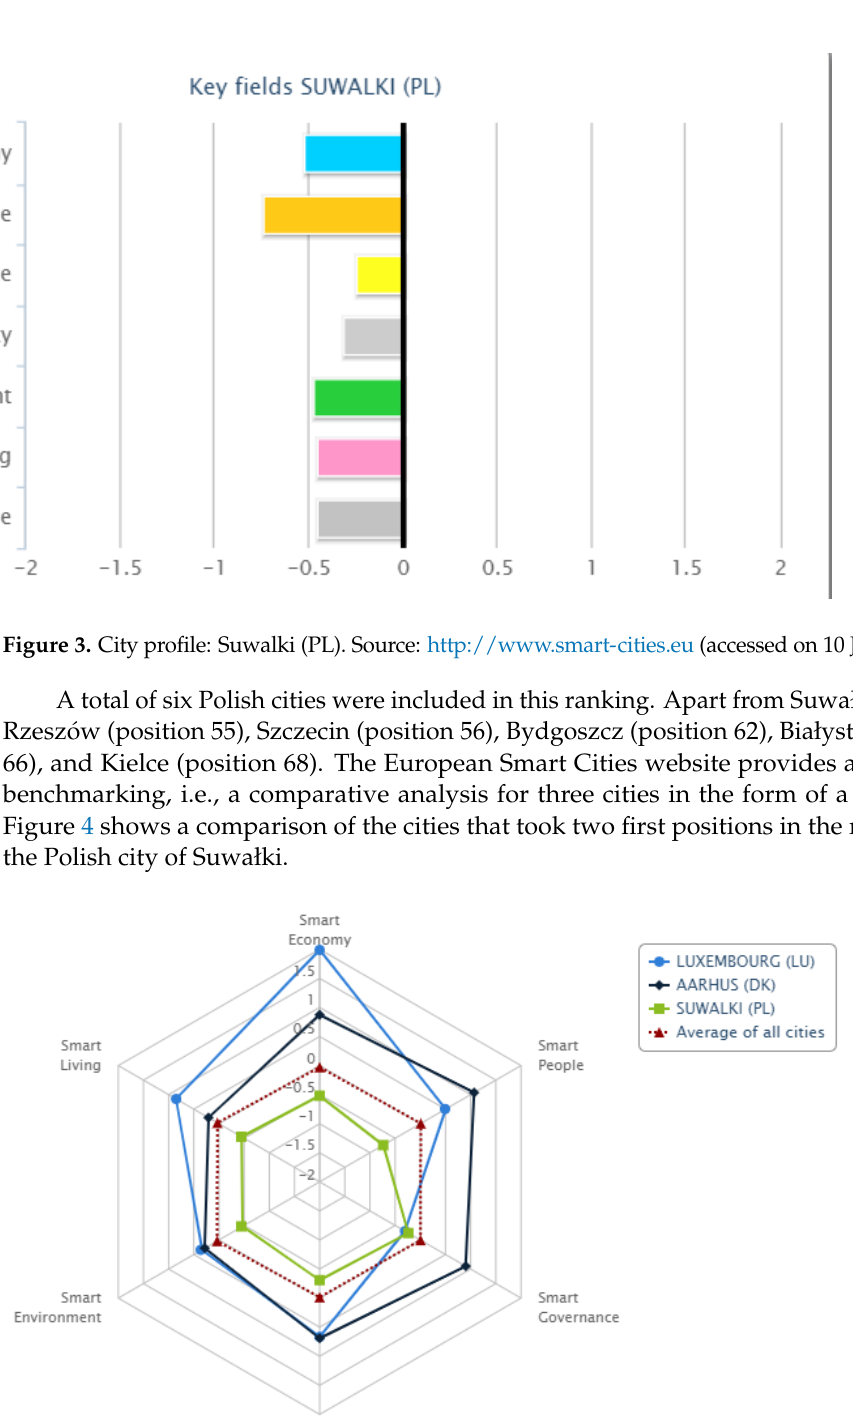
Figure 4. Benchmarking—Luxembourg, Aarhus, Suwałki in six smart city dimensions. Source: http://www.smart-cities.eu (accessed on 10 January 2023).